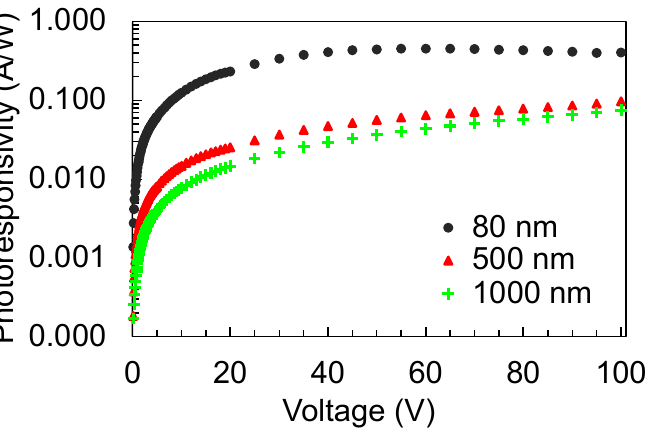
Figure 7. Photoresponsivity of the detectors with 80 nm, 500 nm, and 1000 nm thick TiO 2 film on SiO 2 substrate.